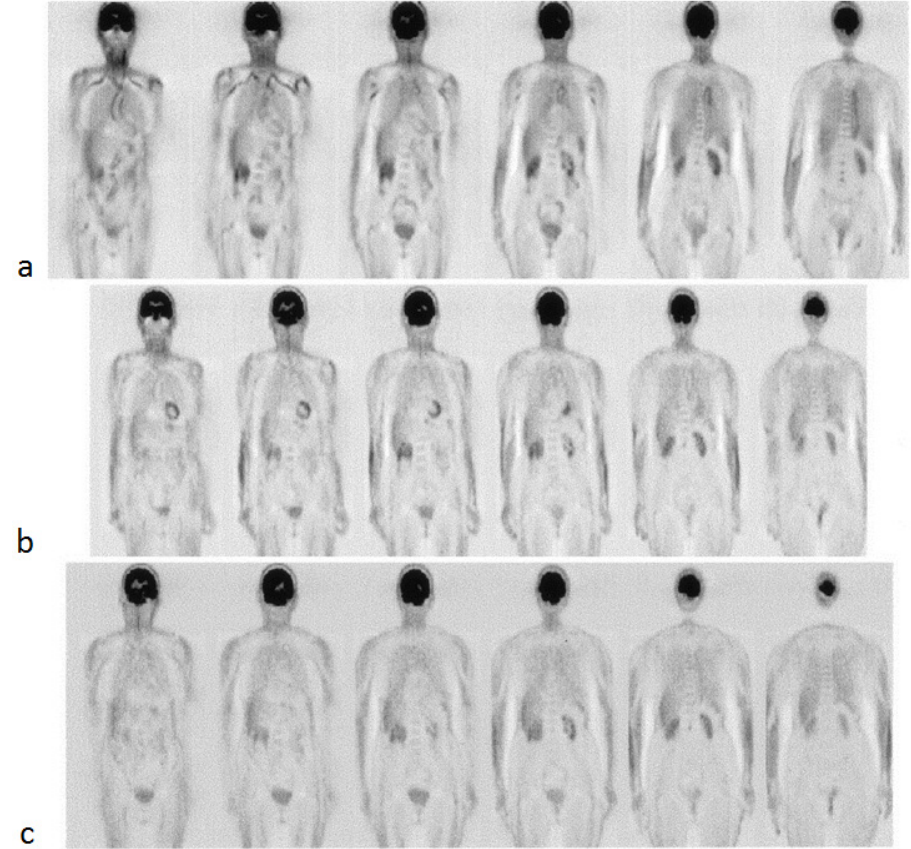
Figure 5. FDG-PET images of a 78-year-old woman with giant cell arteritis at the baseline ( a ), 3 months of therapy ( b ), and 6 months of therapy ( c ). High-tracer uptake is initially present and visible in the thoracic aorta and subclavian arteries, as evident in the first two images from the left ( a ), which progressively decreased after treatment with steroids (from Blockmans et al. [142] with permis-